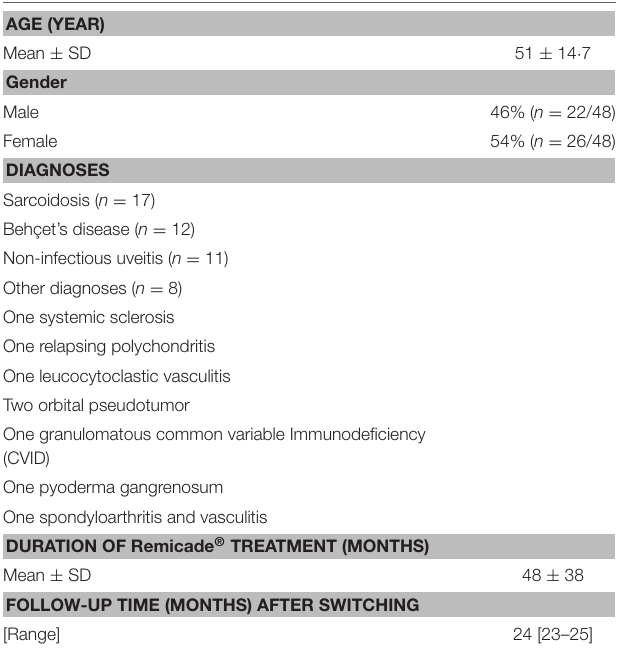
TABLE 1 | Patients baseline characteristics ( n =